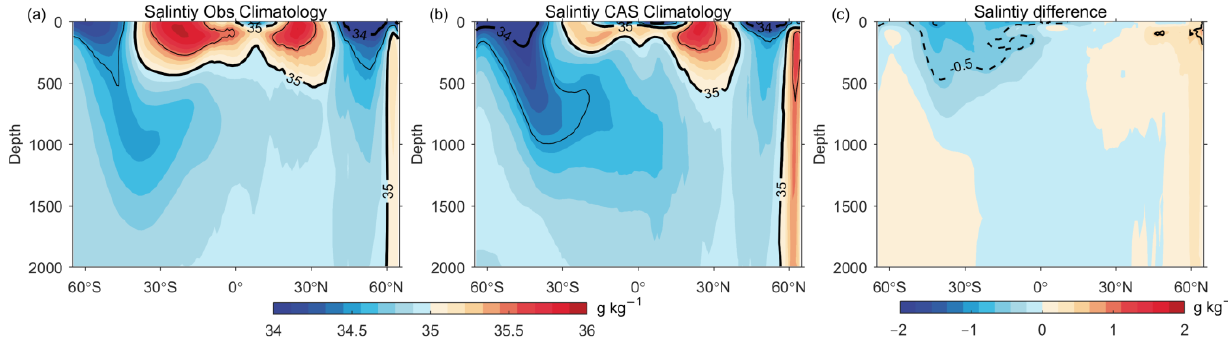
Figure 2. Global climatology of the global zonal mean salinity from the surface to 2000 m: ( a ) for the ensemble means of the four observational products and ( b ) the CAS-ESM2-0 model. ( c ) The difference between the model and observational